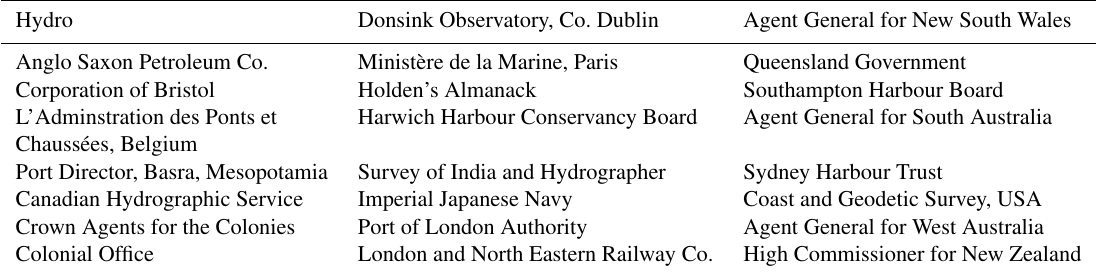
Table 3. TI’s clients (LOTI,